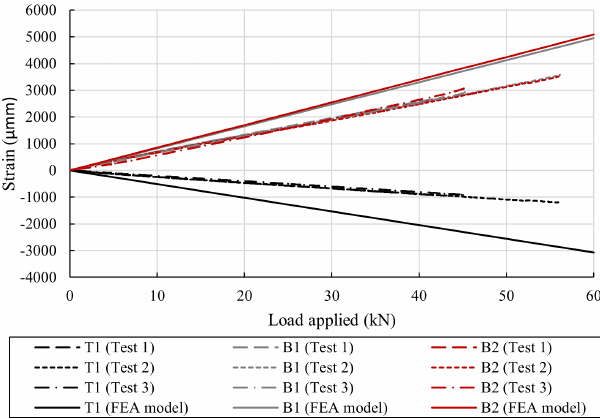
Figure 8. Strain recorded by the three linear strain gauges at the centre of the demonstrator during each